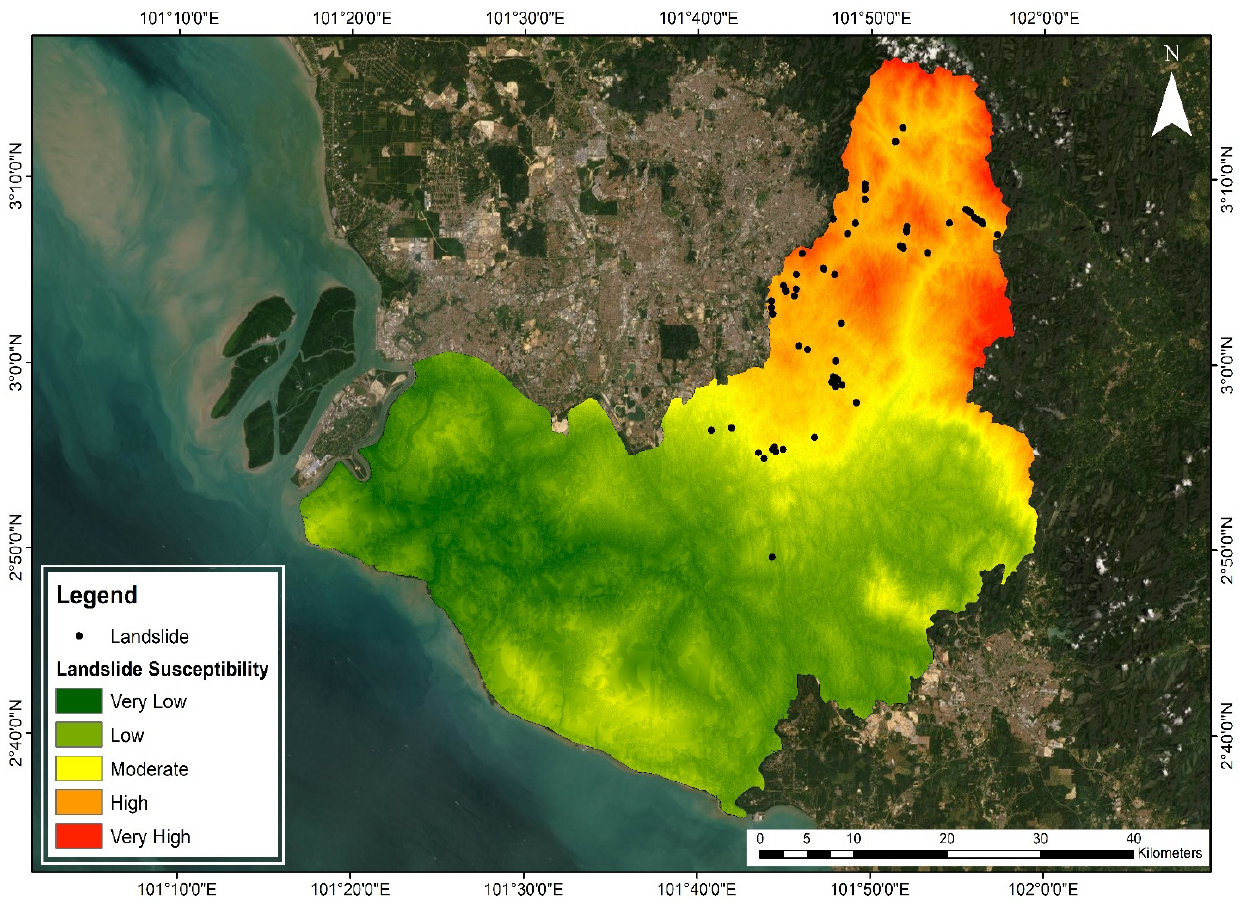
Figure 8. Landslide susceptibility map.